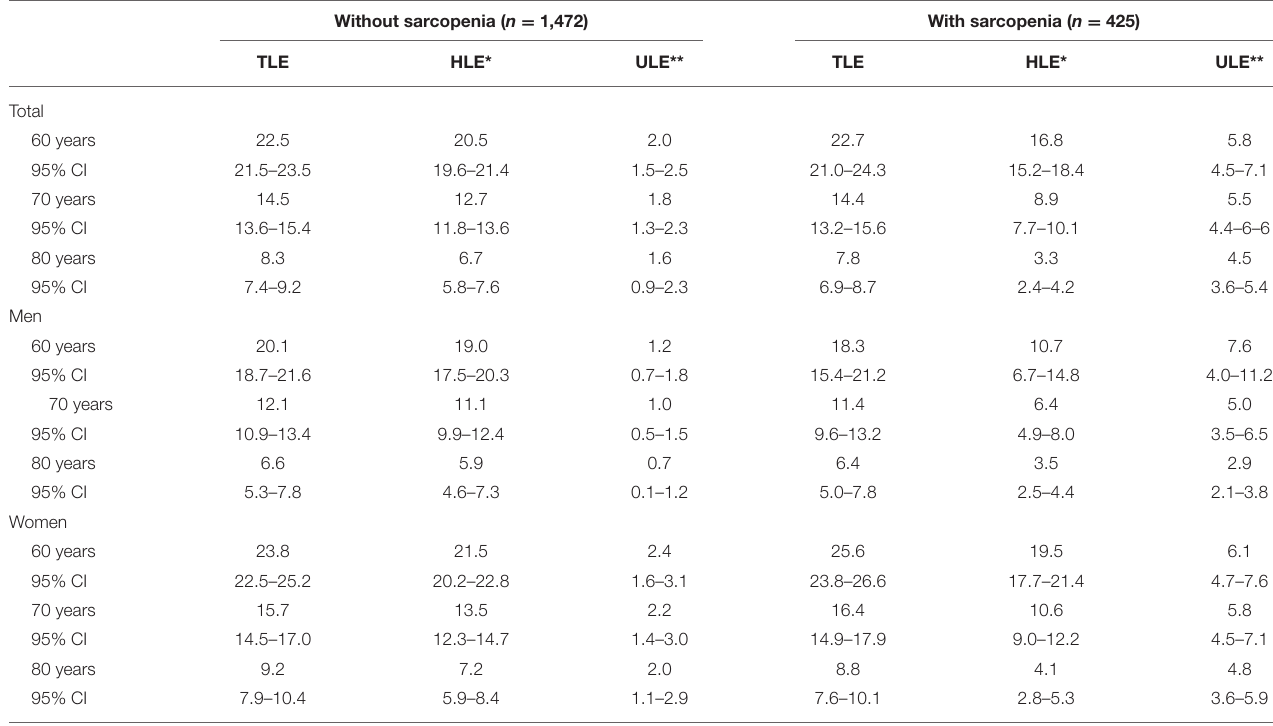
TABLE 2 | Total life expectancy, healthy life expectancy and unhealthy life expectancy, among sarcopenic and non-sarcopenic Chilean older men and